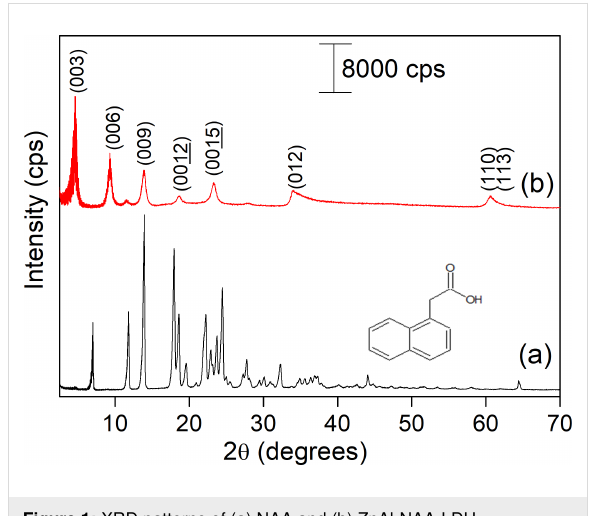
Figure 1: XRD patterns of (a) NAA and (b)